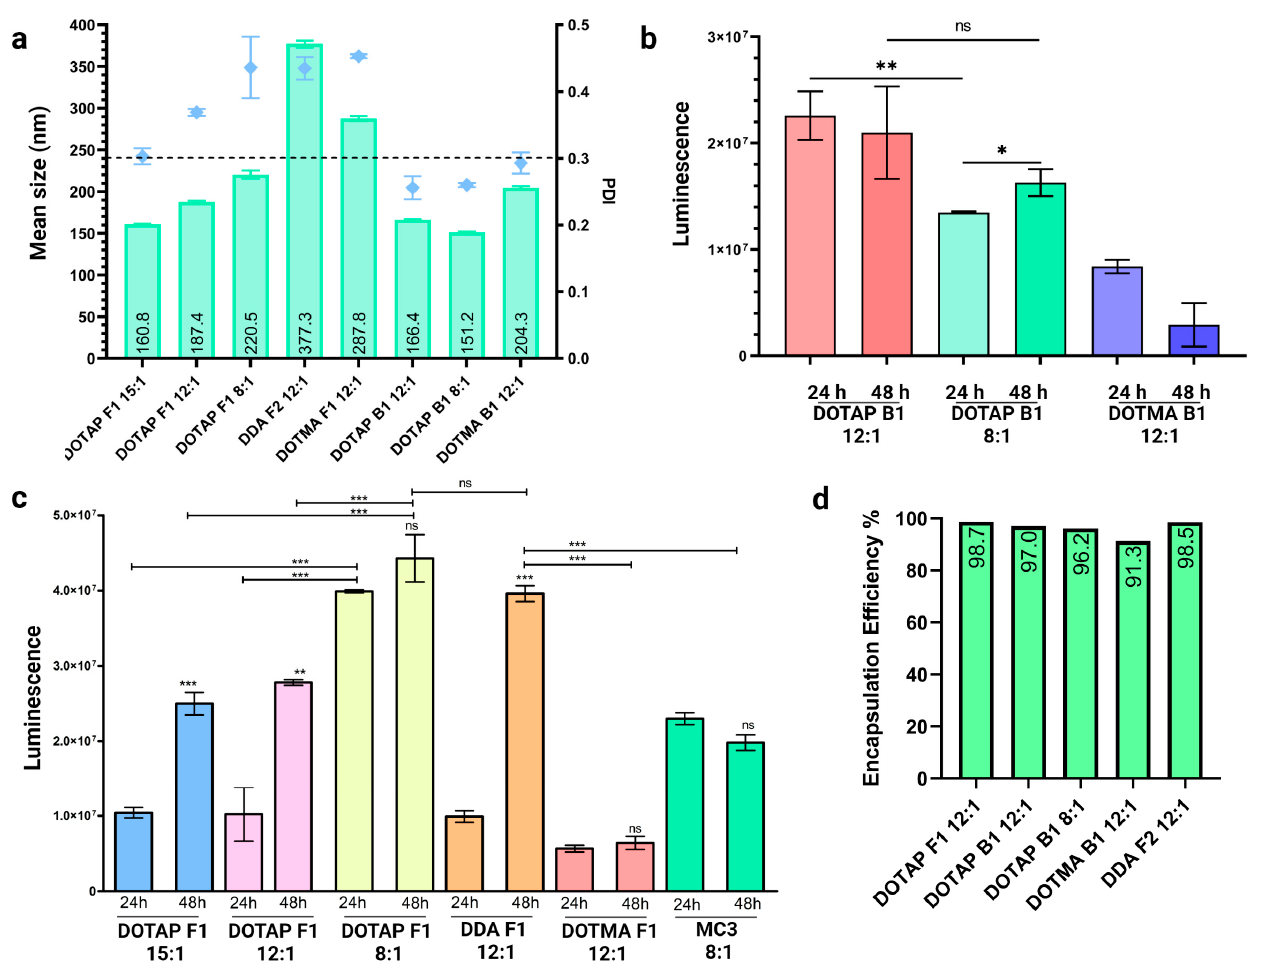
Figure 6. Formulation of saRNA-Int-cLNPs using a modified solvent injection method. ( a ) saRNA-Int-cLNPs were formulated using a modified solvent injection method. This method of incorporating saRNAs inside the cLNP generated particles that were generally larger, ranging from 151.2–377.3 nm, with sub-optimal PDIs. ( b , c ) Transfection of HEK293 cells with saRNA-Luc2-cLNP formulations comprising DOTAP, DOTMA, or DDA all achieved delivery of saRNA-Luc2. At 48 h post-transfection, luminescence signals increased in DOTAP B1, DOTAP F1, and DDA F1 suggesting amplification of the transcript was achieved. Once again, formulation composition, as well as N:P ratios were vitally important for optimal delivery and expression kinetics. saRNA-cLNPs formulated using the solvent injection method outperformed a standard MC3-based saRNA-iLNP formulation prepared using microfluidics. ( d ) As with exteriorly formulated saRNAs, interiorly formulated saRNAs showed high (>90%) encapsulation efficiency. Results are depicted as the mean, with standard error of the mean. Significant differences were calculated using a Student’s t -test. ns = not significant, * p < 0.05, ** p < 0.01, *** p < 0.001. Created using GraphPad prism 4 and 5 and BioRender.com.